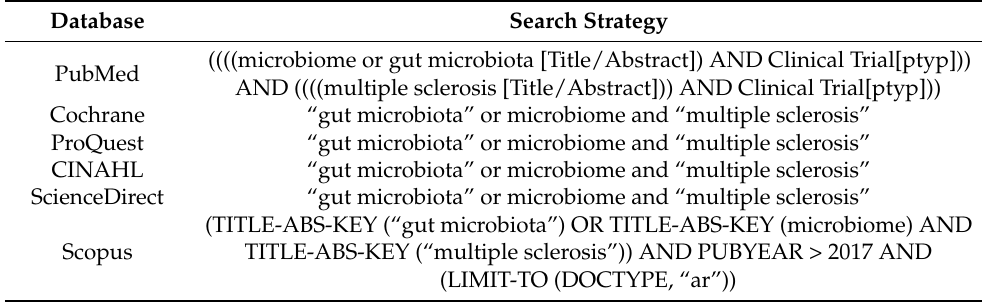
Table 1. Description of the research strategies performed in each database. Database Search Strategy